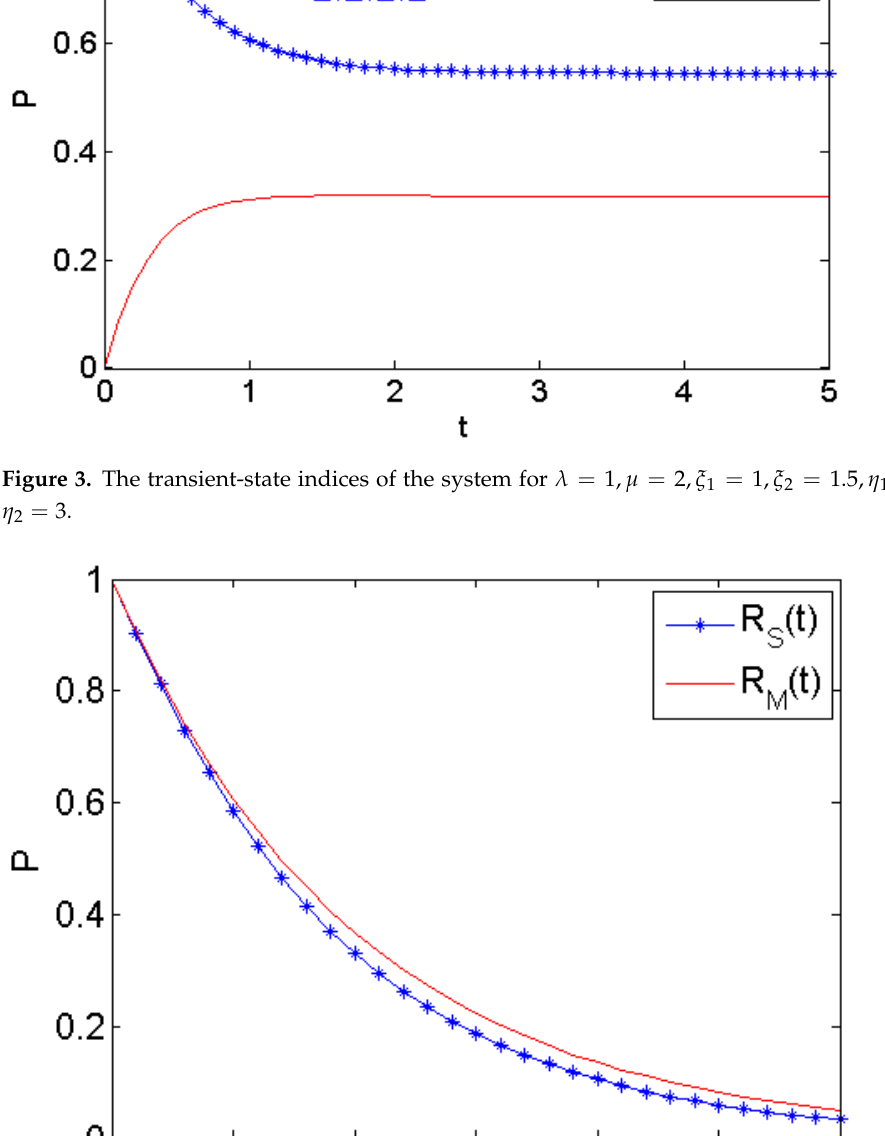
R t and the server M